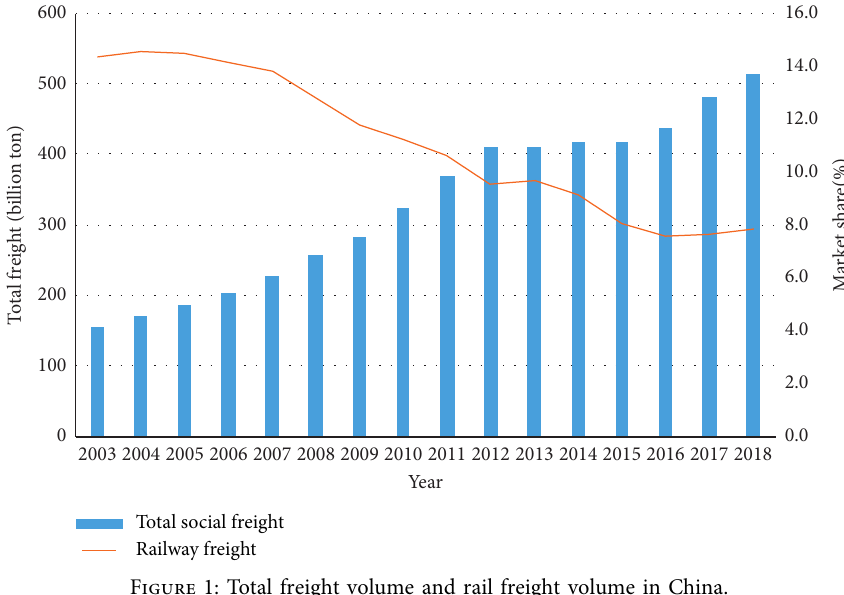
Figure 1: Total freight volume and rail freight volume in